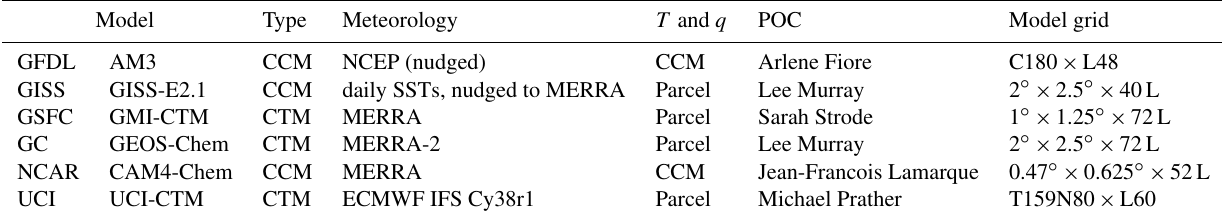
Table 1. Participating